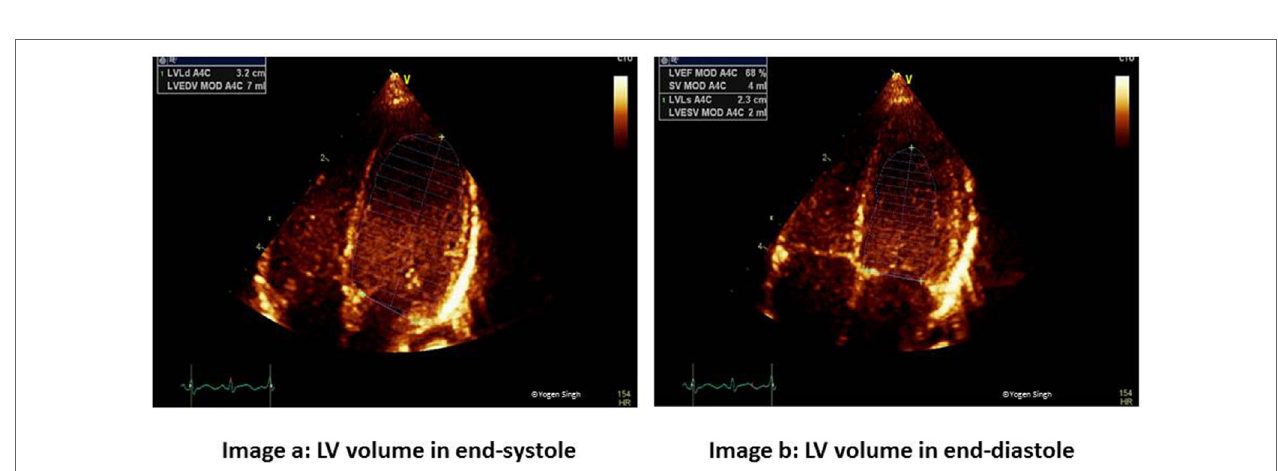
FiGURe 3 | Simpson’s biplane method for measurement of ejection fraction (EF). Image a shows left ventricular end-diastolic volume (LVEDV) and image b shows left ventricular end-systolic volume (LVESV) measurements in apical four-chamber view to calculate EF. Similar measurements are done in apical two-chamber view.